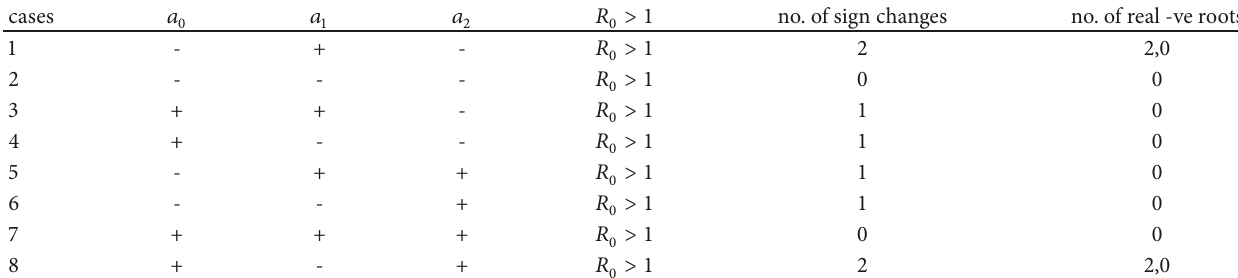
Table 1: Roots of characteristic equation